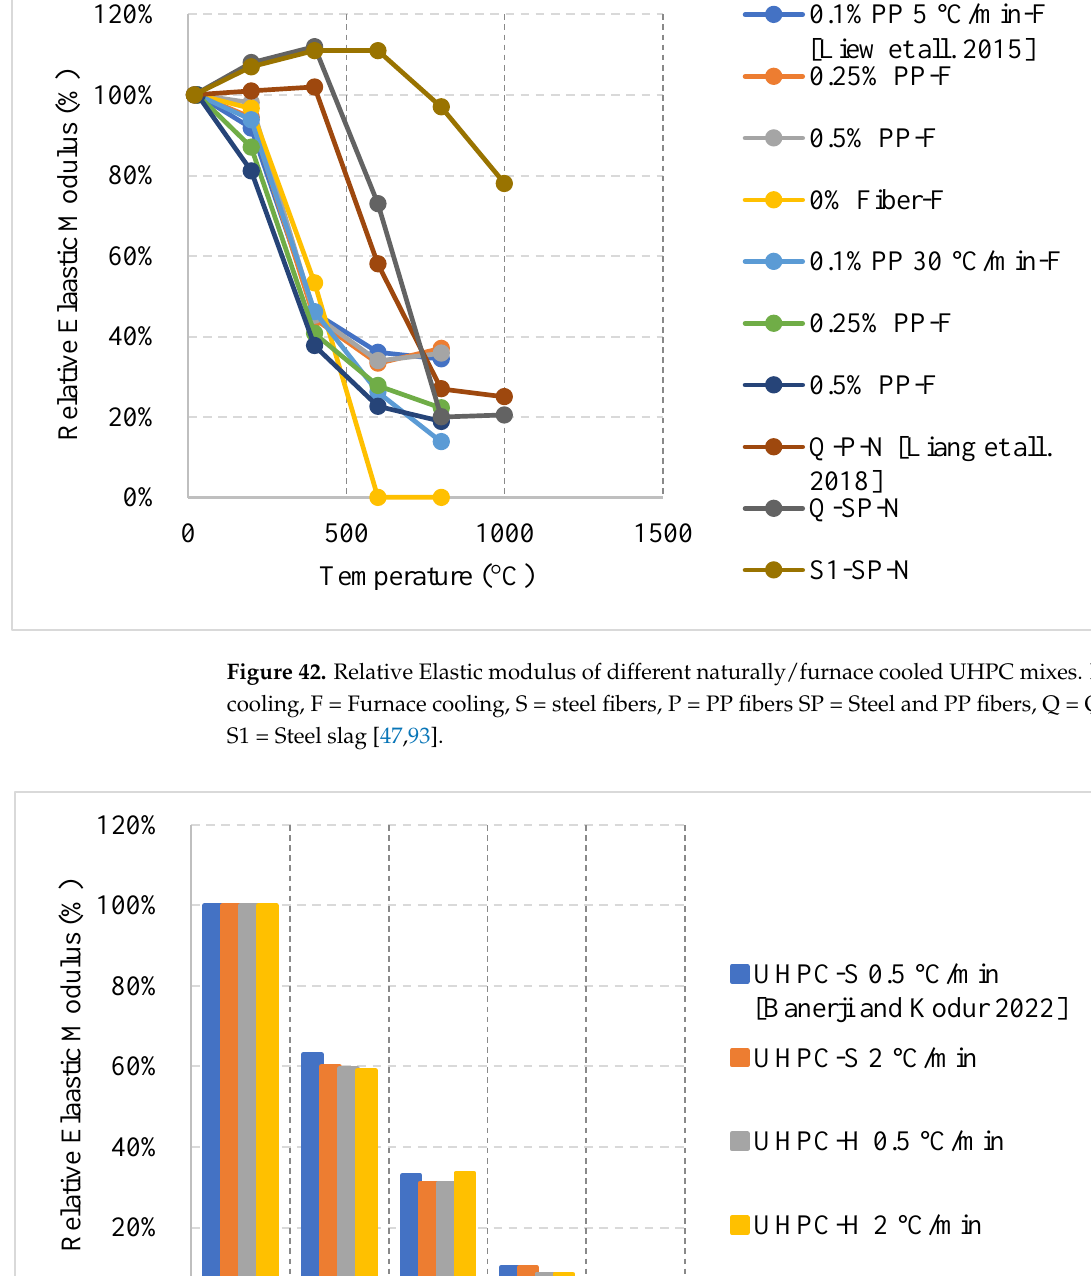
Figure 41. Relative Elastic modulus of different naturally cooled HSC mixes [76].